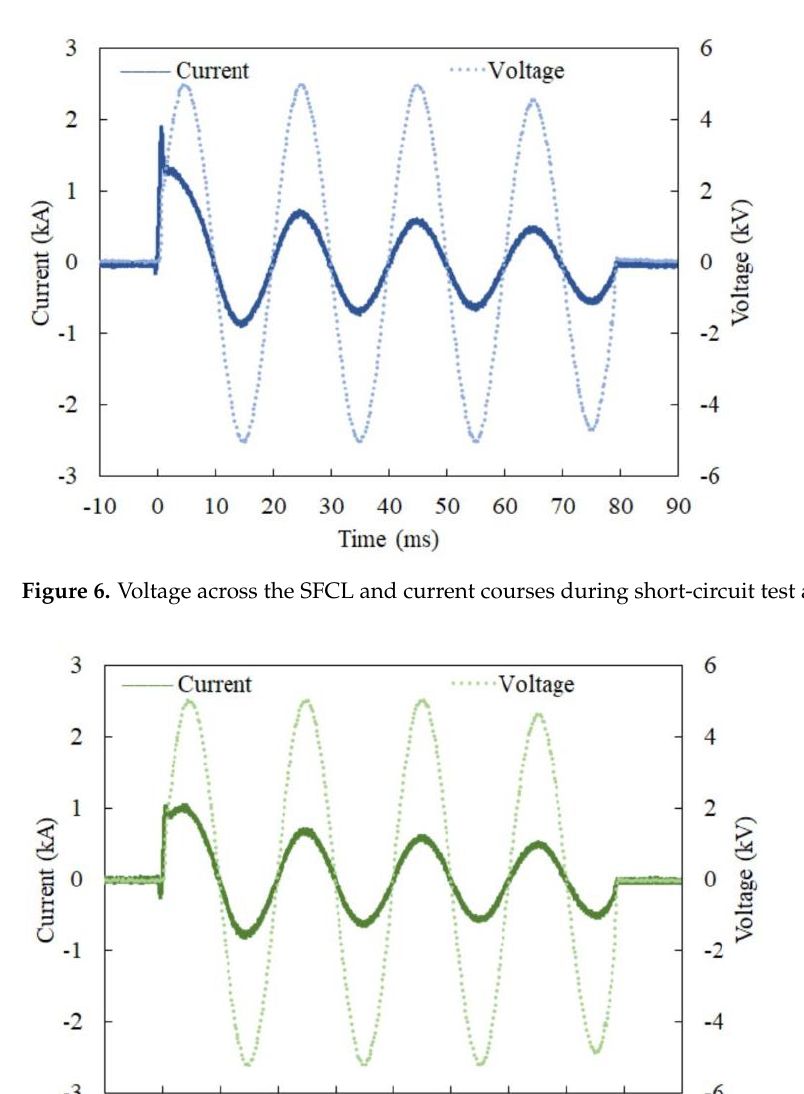
Figure 8. A comparison of current courses in the circuit with and without the limiter. The limiter was tested at 72 K and at 80 K to compare the current in the circuit with the limiter to the current in the circuit without the limiter. In nominal conditions, the cur- rent passes through the compensated windings, and the voltage on the limiter is less than 0.2 V. During a short-circuit, the resistance of the superconducting windings increases.